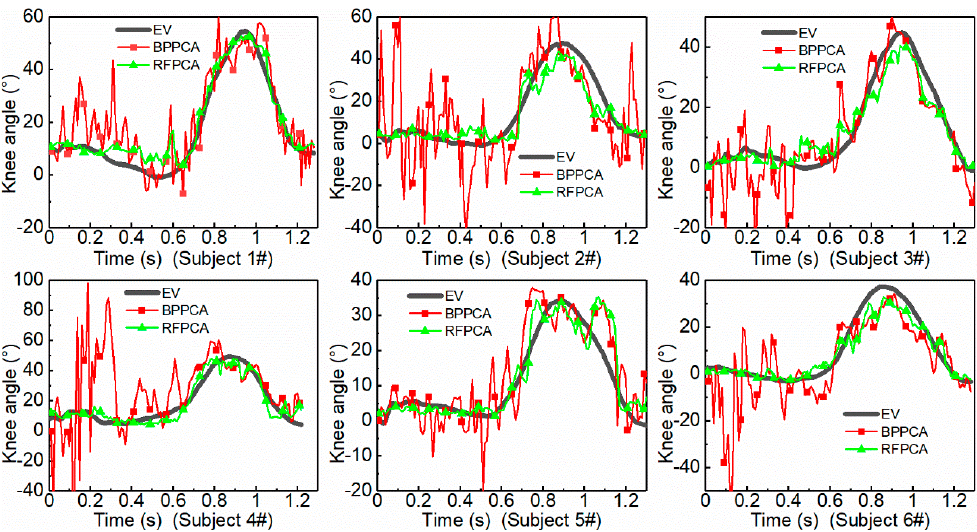
Figure 9. The estimation results of different models from different subjects when n = 2.